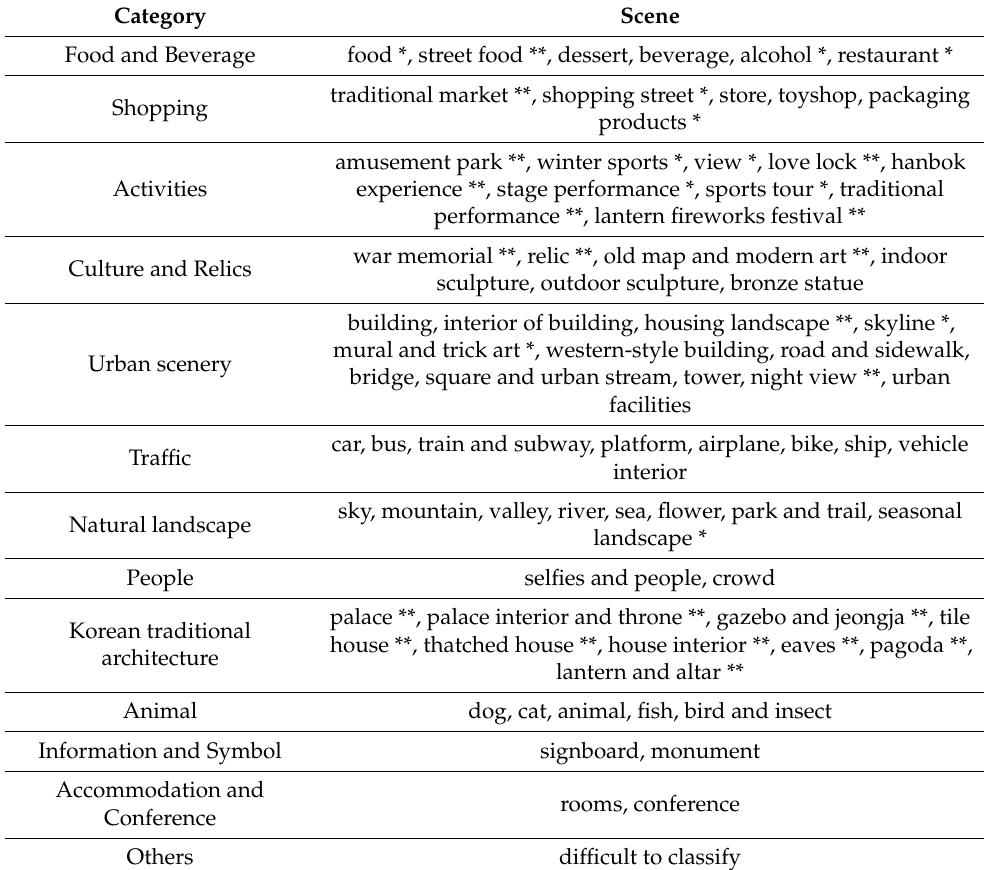
Table 1. Classification of tourists’